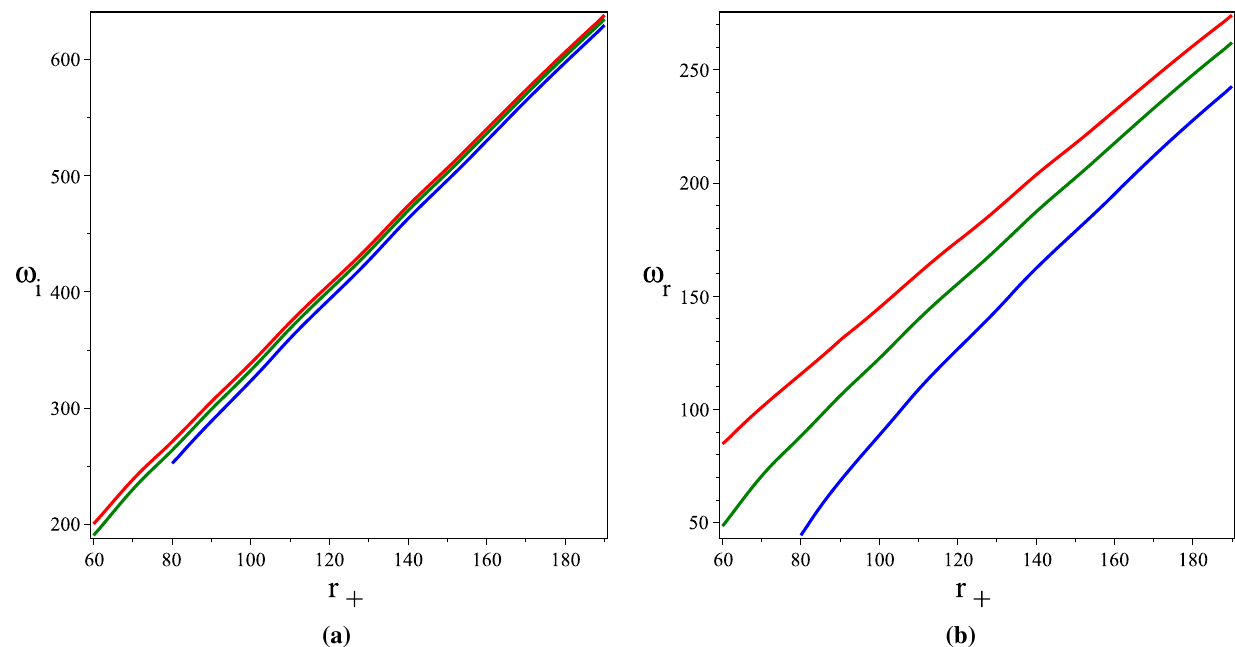
Fig. 9 The behavior of ω i and ω r in terms of r + for Q = 5 , 25 , 40 , b = 1 , l = 0